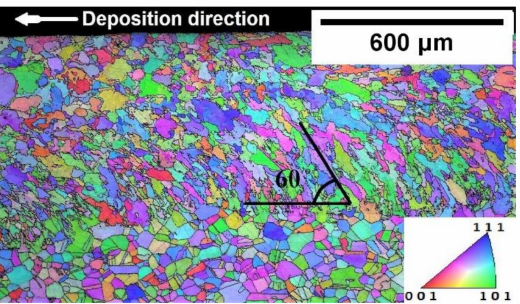
Figure 6. EBSD orientation map for longitudinal section deposited WPH with IPF